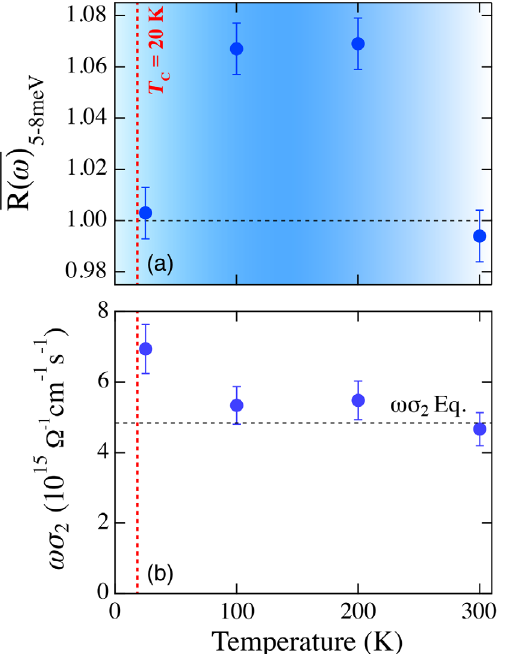
FIG. 5. (a) Inferred local transient reflectivity (sample- FIG. 6. (a) Inferred local transient reflectivity (sample-diamond diamond interface), averaged between 5 and 8 meV, as a interface) averaged between 5 and 8 meV, as a function the initial function of the pump-pulse duration. The blue-shaded region temperature. The blue-shaded region indicates the temperature indicates the range of pulse durations where amplification is range where amplification is observed. (b) Temperature depend- observed. (b) ωσ 2 ð ω → 0 Þ ¼ Λ , which is proportional to the ence of ωσ 2 ð ω → 0 Þ ¼ Λ , which is proportional to the transient s s transient superfluid density, extracted by a low-frequency 1 = ω superfluid density, extracted by a low-frequency 1 = ω fit to the fit to σ 2 ð ω Þ . All data were taken at T ¼ 100 K and a constant transient σ 2 ð ω Þ . The red dashed lines indicate the equilibrium pump fluence of 4 . 5 mJ = cm 2 . superconducting transition temperature T c ¼ 20 K of K 3 C 60 . All data were taken at a constant pump-pulse duration of 100 fs and a constant pump fluence of approximately 5 . 5 mJ = cm 2 (which is somewhat larger than the fluence in the data in Figs. 4 and